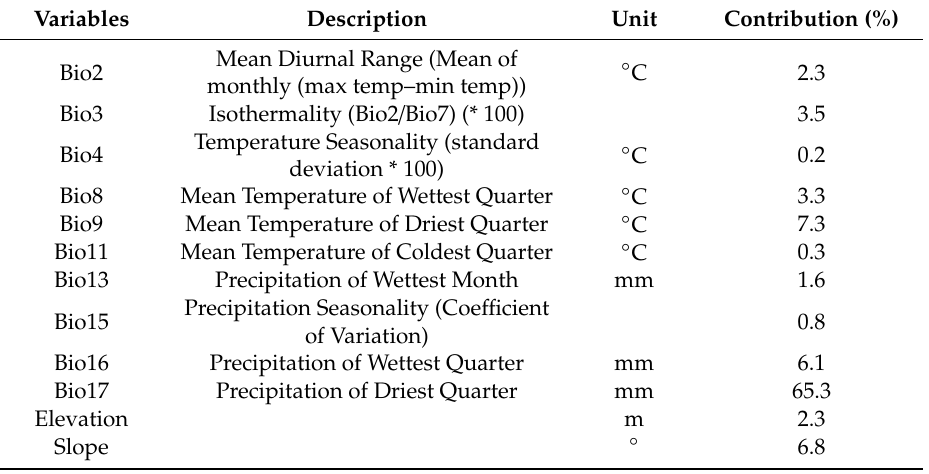
Table 3. Environmental variables used in the MaxEnt model and their percent